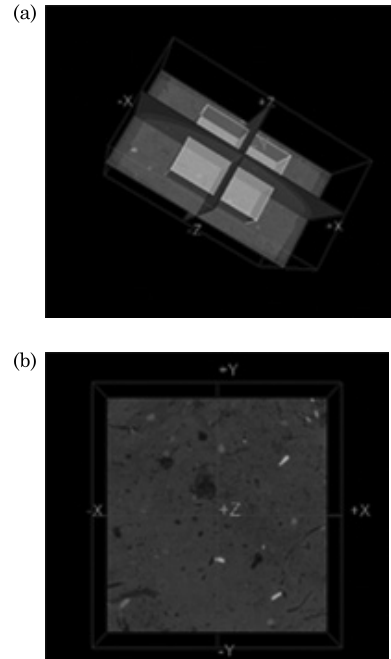
figure 1. (a) sub-volume (x=4.2 cm, y=4.2 cm and z=3.3 cm; V=58.2 cm 3 ) selected for the reconstruction and (b) 16 bit image rebuilt with 60 µm image resolution. in this image, the less dense materials (pores) in the sample are represented in darker gray, and the denser ones (minerals) in lighter